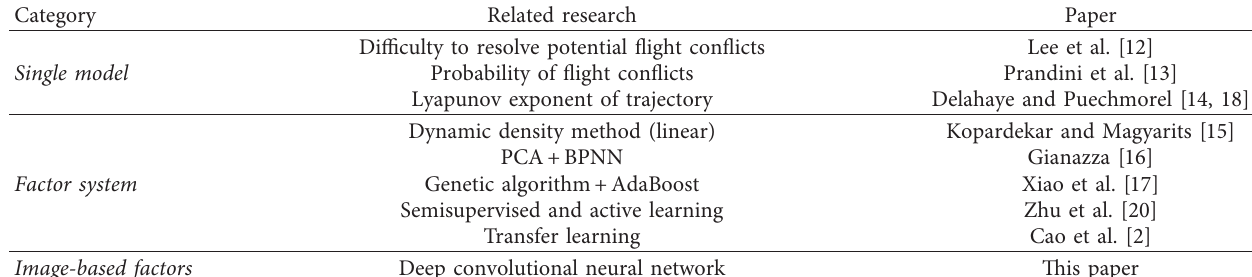
Table 2: Summary of previous works in air traffic complexity